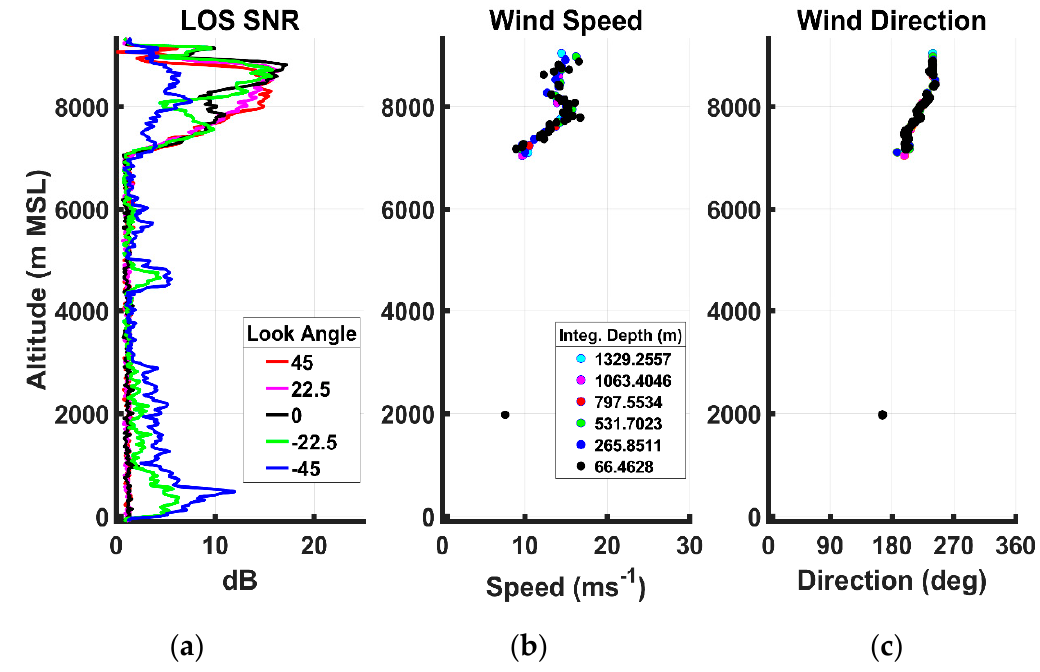
Figure 26. DAWN vertical profiles of SNR ( a ), wind speed ( b ) and wind direction ( c ) in convective region at 183532Z on 11 June 2017.